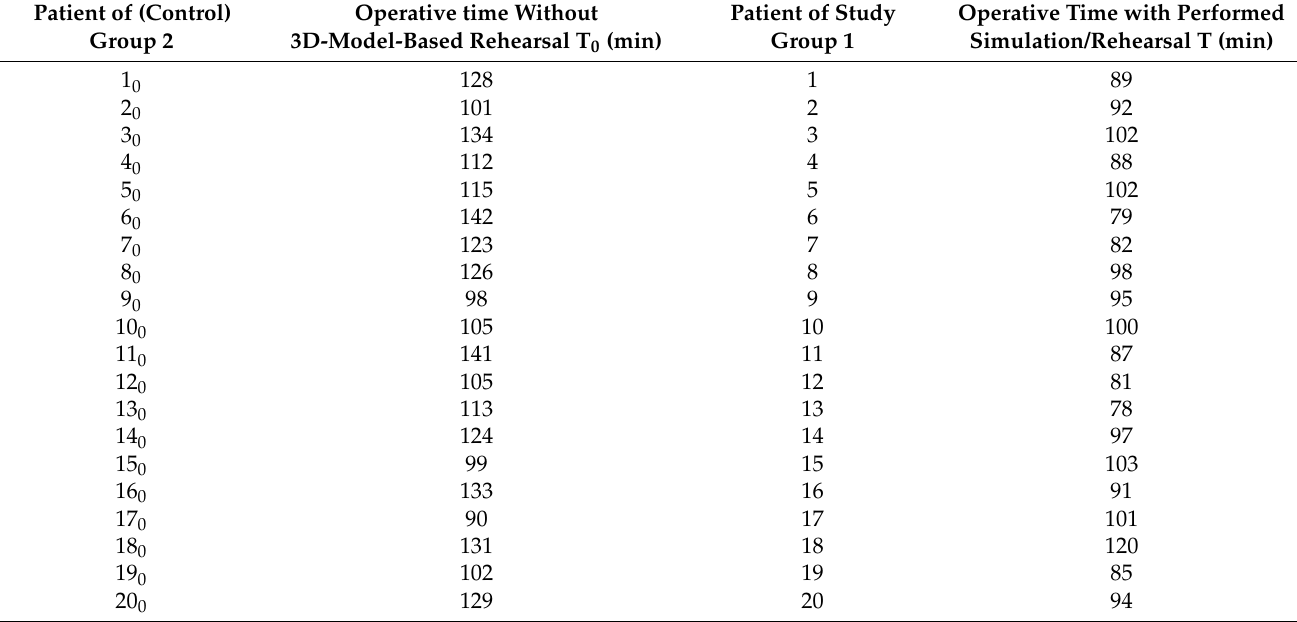
Table 6. Operative time intervals of implant procedures without ( T 0 ) versus with 3D-model-based simulations/rehearsals ( T ). Patient of (Control) Operative time Without Group 2 3D-Model-Based Rehearsal T 0 (min)